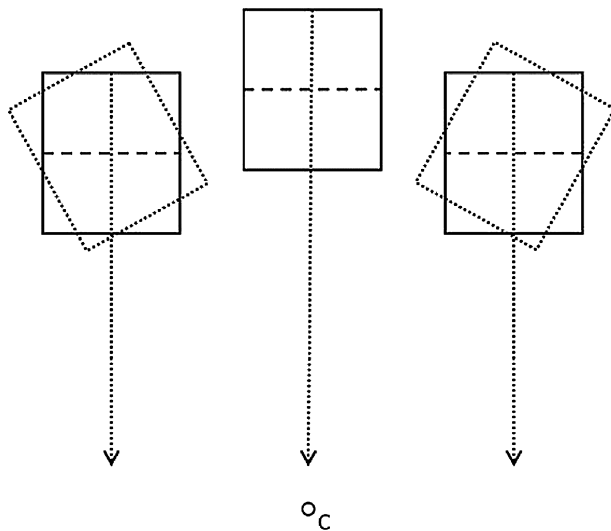
FIG. 7. Converting rectangular magnets facing the machine center (dotted line) to rectangular magnets aligned parallel with each other (solid line).